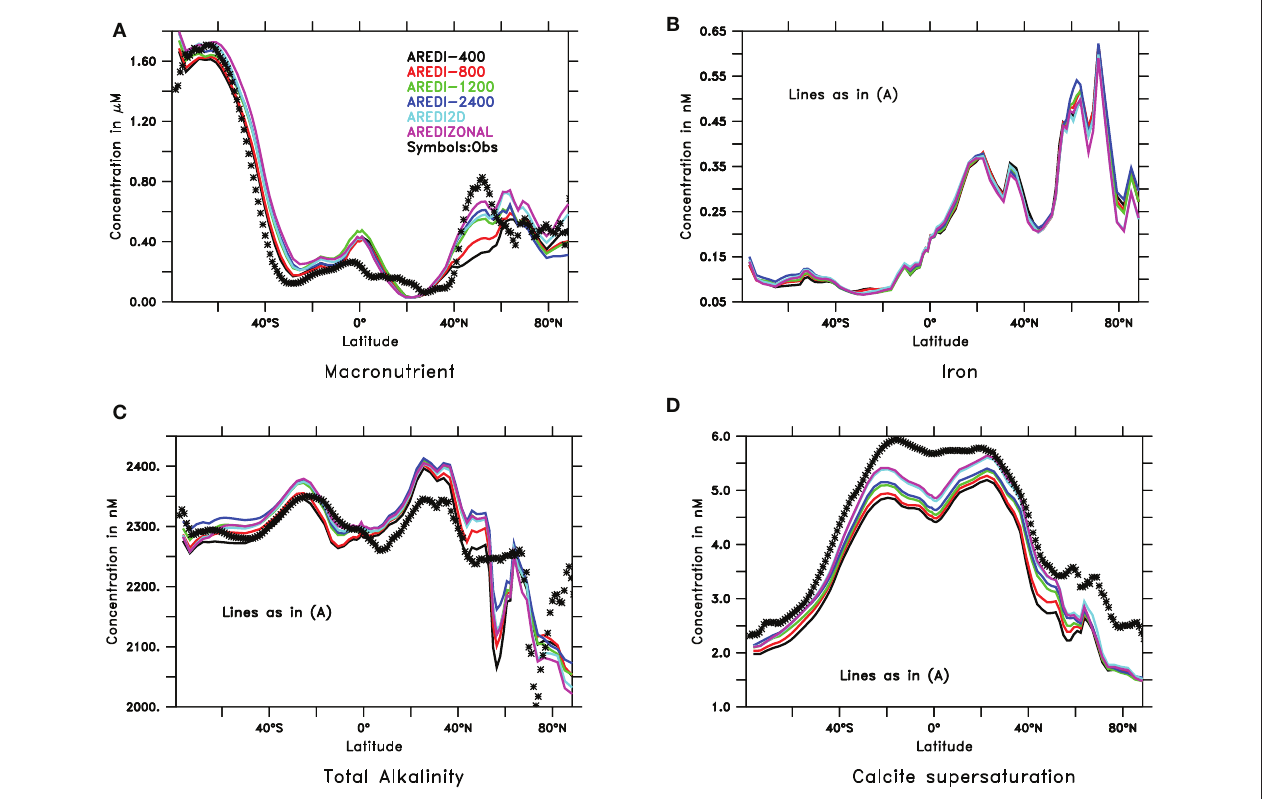
FIGURE 2 | Zonally averaged annual mean surface chemical fields in CM2Mc pre-industrial control run with six different A REDI parameterizations compared to observations (symbols). Iron observations are not included due to a lack of reliable data. (A) Phosphate [ µ M, obs. from WOA09, Garcia et al. (2010)] (B) Iron (nM), (C) total alkalinity [ µ M, obs from Lauvset et al. (2016)], and (D) calcite supersaturation [non-dimensional, obs from Lauvset et al. (2016)].